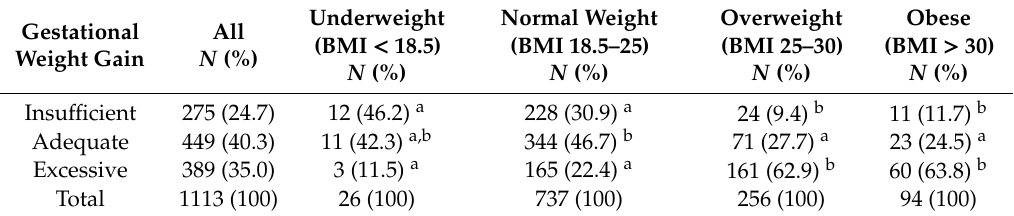
women and per first trimester BMI